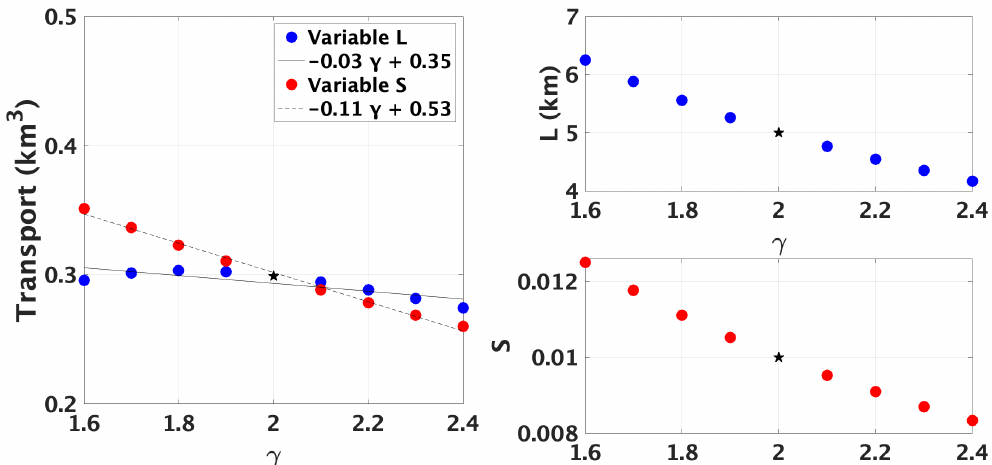
Figure 7. ( Left ) Cross-shelf transport across the surface Ψ = 0 for a variety of values of γ , as defined in Table 2. The blue data points correspond to changes in the denominator and red data points to changes in the numerator. Lines show linear fits to the data series separately. ( Right, top ) Values of L corresponding to the values of γ used to derive the blue data points. ( Right, bottom ) Values of S corresponding to the values of γ used to derive the red data points. The black star in all panels shows the data point for the base